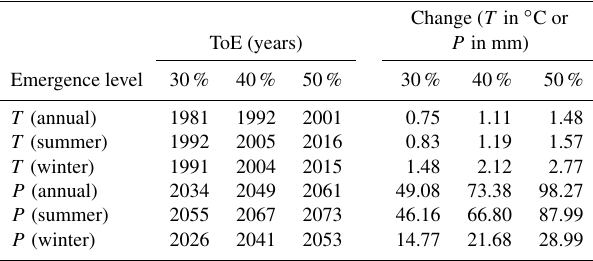
Table 2. The area-wide ToE based on the mean HD of all 65 CMIP5 model simulations and the corresponding change in temperature or precipitation at different emergence levels (HD) and